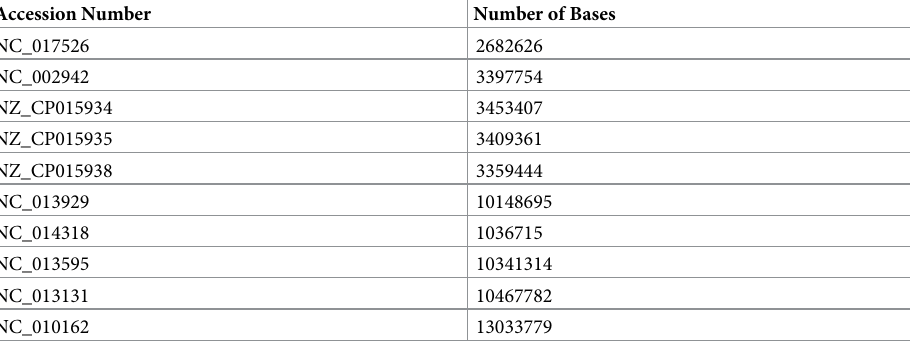
Table 2 is the compression ratio, compression time and decompression time of our method and the fastest method. Table 1. The datasets.